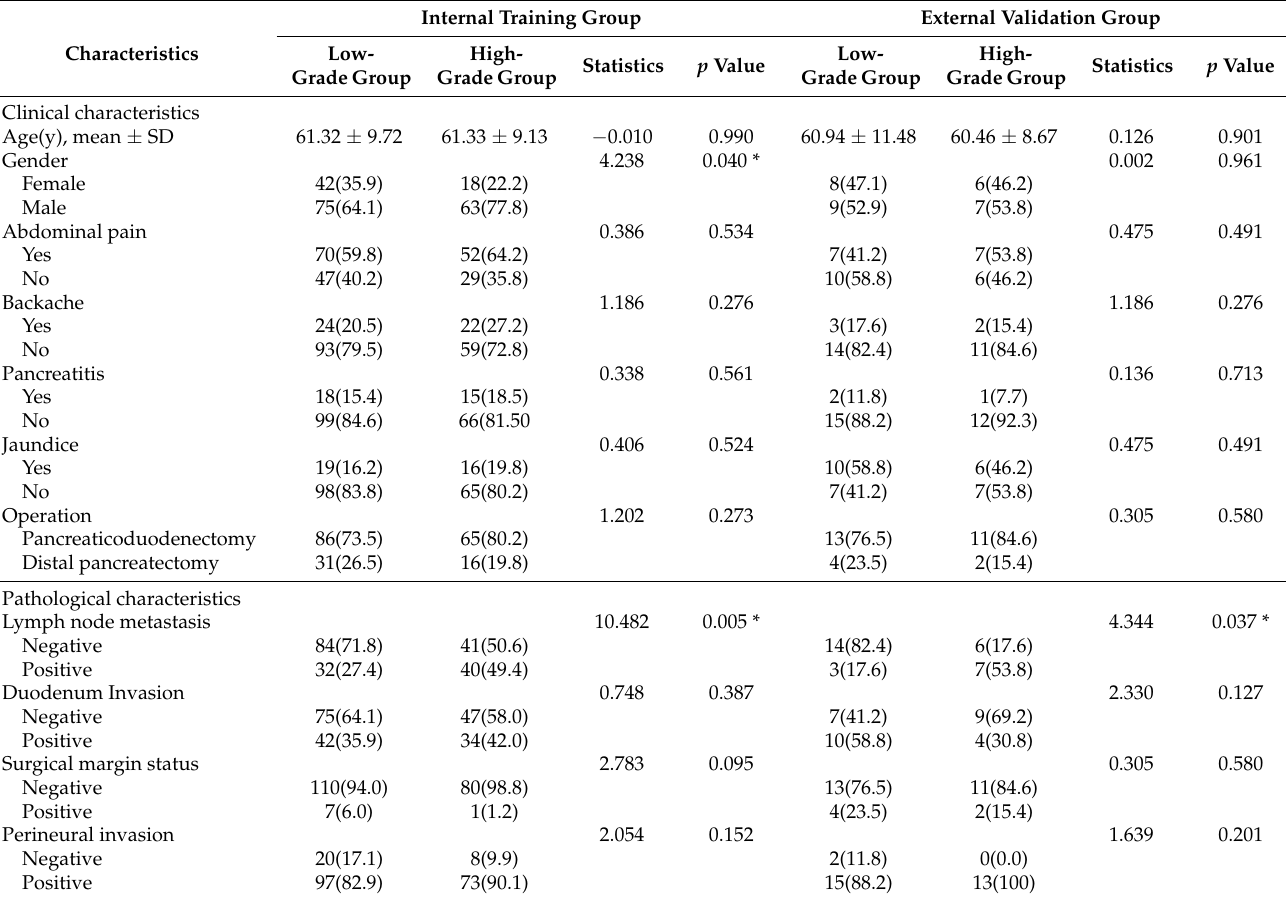
Table 1. Baseline characteristics of patients with